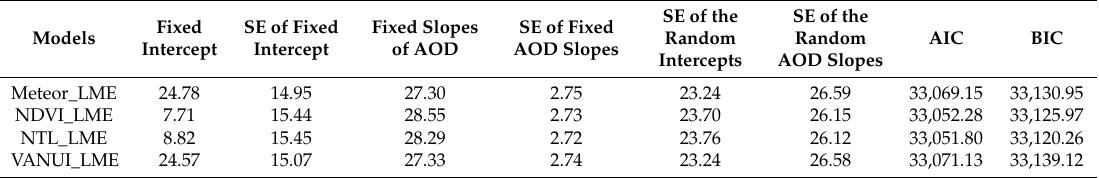
Table 2. Fixed effects and random effects for models and model